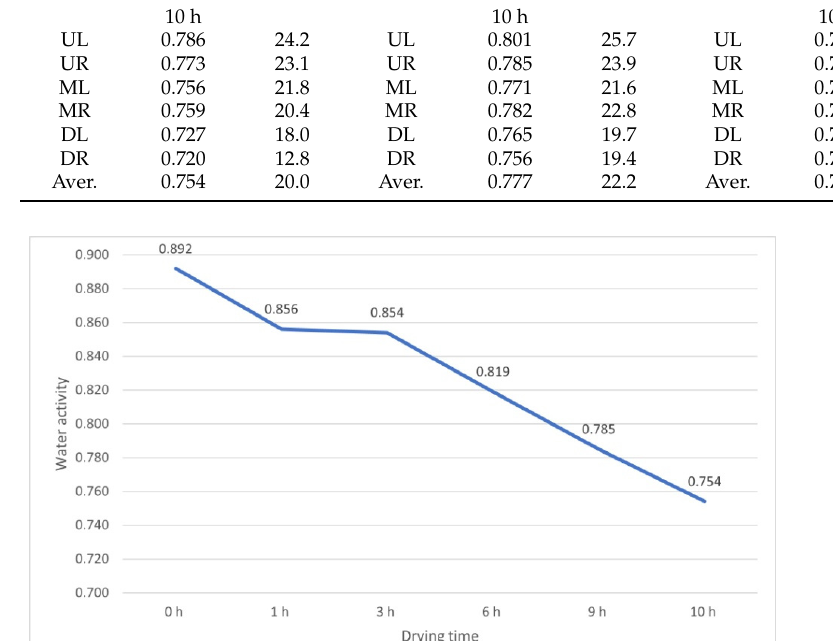
Figure 19. Comparison of changes in water activity (Wa) of beef samples in chamber 5 depending on sampling location.